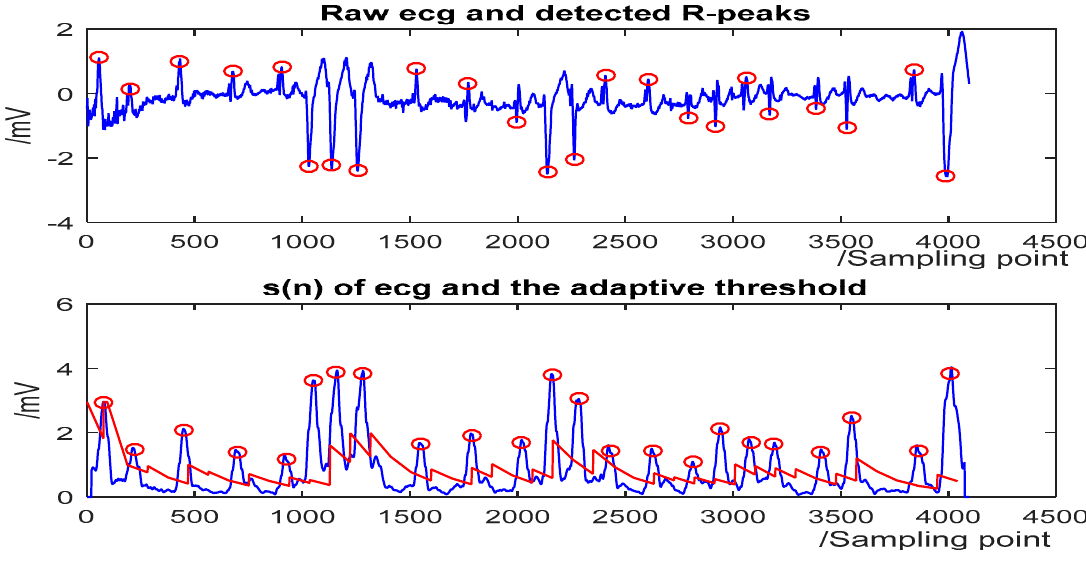
Figure 4. The QRS-complex detection result of record 203 in the MIT-BIH Arrhythmia Database with premature ventricular contractions (PVC) and small normal QRS. ( Top ) the original ECG and detected R-peaks (red circle). ( Bottom ) s(n) in record 203 and the threshold (red line).